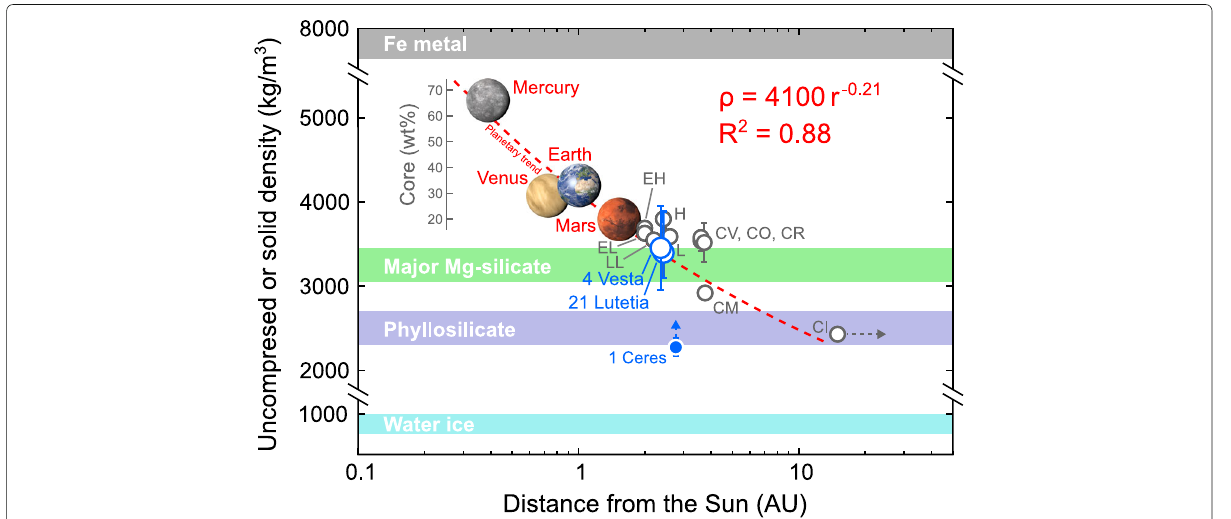
Fig. 4 Density of the rocky solar system bodies. Uncompressed and solid densities are shown for terrestrial planets and chondrites (gray), respectively. Bulk planetary densities are shown for asteroids (blue). For 1 Ceres, its bulk density is a lower limit of its solid density, given its high ice abundance and porosity. The red line shows a fit curve for the planets ( ρ = 4100 r − 0.21 ). Data sources: density of planetary bodies are from Russell et al. (2012); Park et al. (2019); Sierks et al. (2011); Consolmagno et al. (2006); Macke et al. (2010); Macke et al. (2011); Britt and Consolmagno (2003); Lewis (1972); Stacey (2005); heliocentric distances of chondrite parent bodies are from Desch et al.